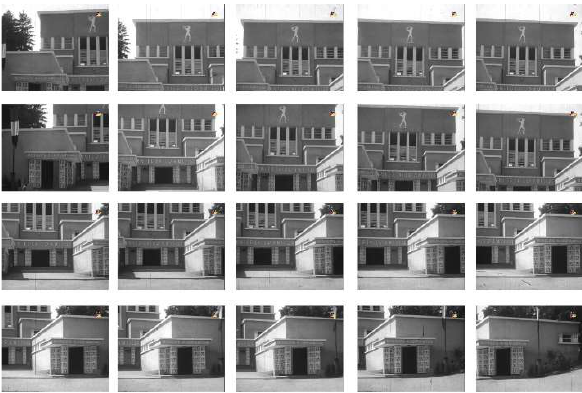
Figure 5. A selection of the frames extracted from the video “Torino 1928” in which the pavilion of “Mines and Ceramics”